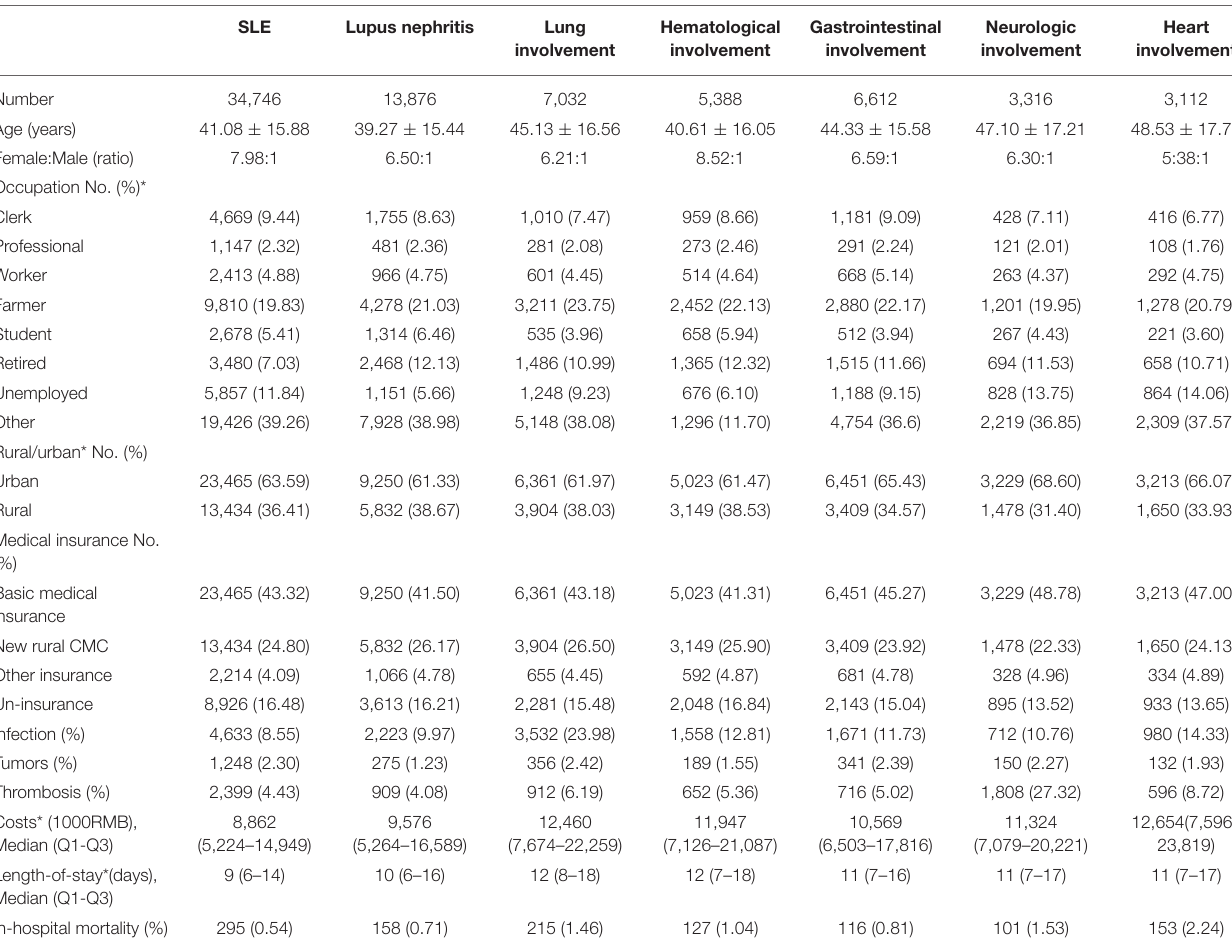
TABLE 1 | Selected characteristics of SLE patients with different organ involvements in 2017.